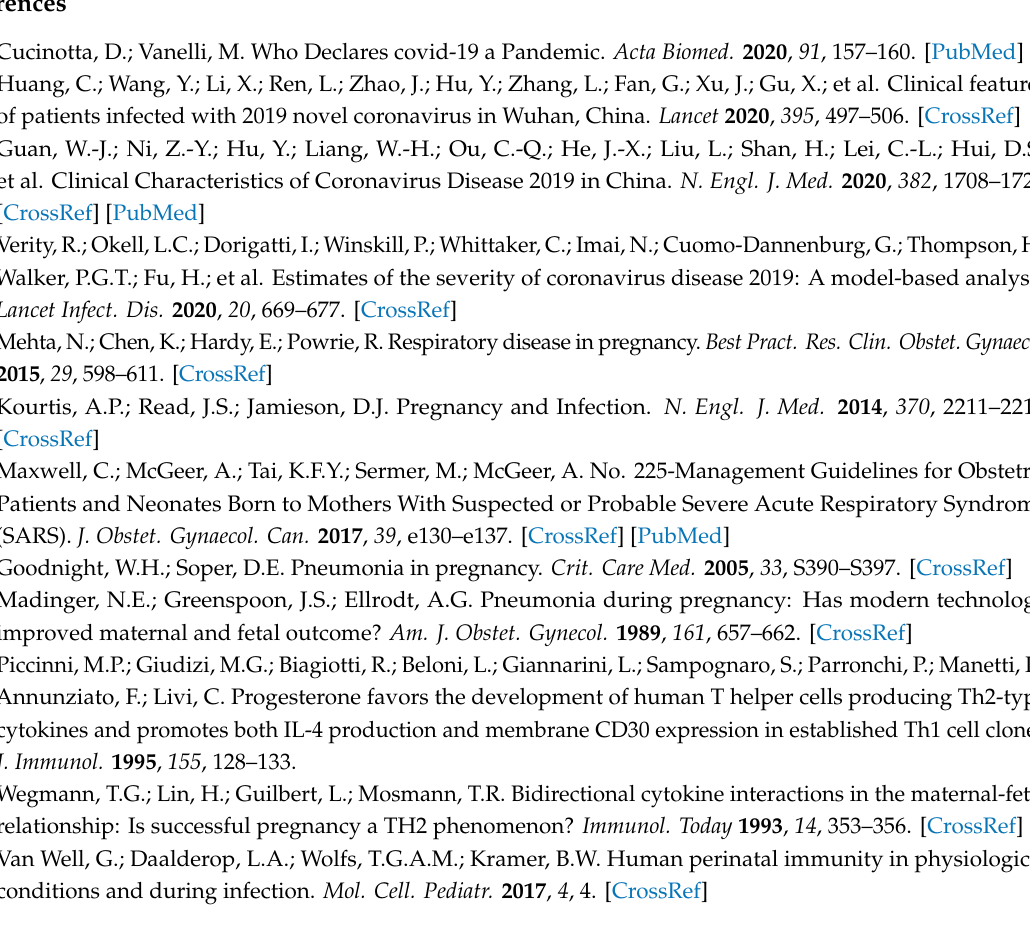
Table S1: Checklist summarizing compliance with PRISMA guidelines, Table S2: Search strategy, Table S3: Reason for exclusion during full text screening, Table S4: Detailed description about basal characteristics of included